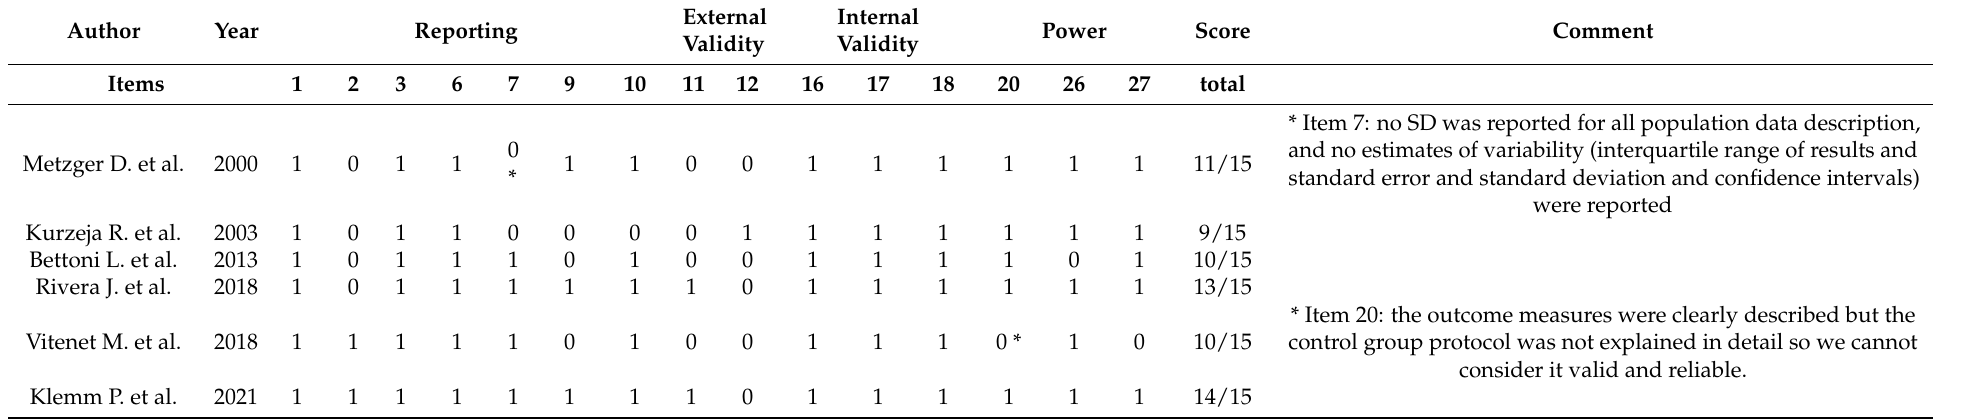
Table 1. Quality assessment of the included original articles (Downs & Black quality analysis tool). Abstracts are excluded from the assessment.